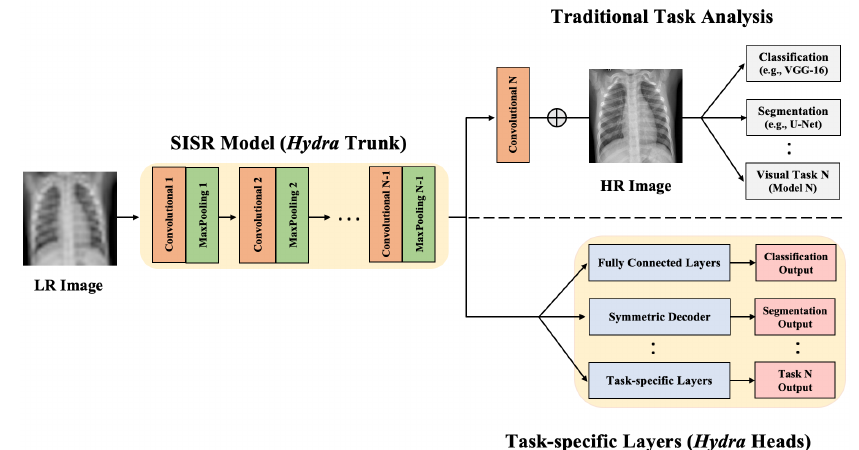
Figure 1. Illustration of the traditional approach and proposed Hydra for image enhancement and visual task analysis. The SISR model ( Hydra trunk) is used to learn the mapping from LR to HR. In the traditional approach, the constructed HR image is used as input to different models; e.g., segmentation and classification models. In the proposed Hydra , the learned SISR model is used as a shared trunk and appended with task-specific heads. The detailed architecture of Hydra trunk is shown in Figure 2.